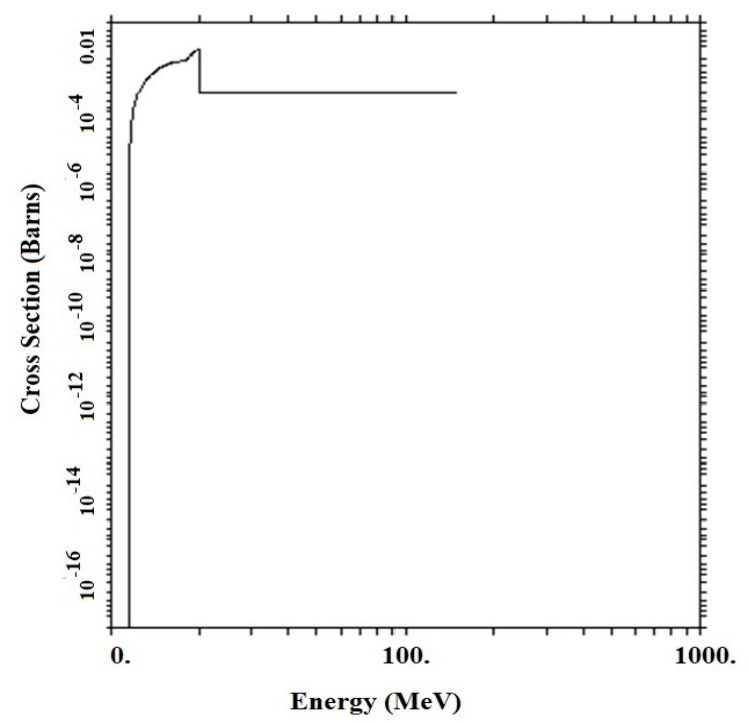
Figure 7. A X (n, 2n) A − 1 X cross ‐ section in concrete composite structure.